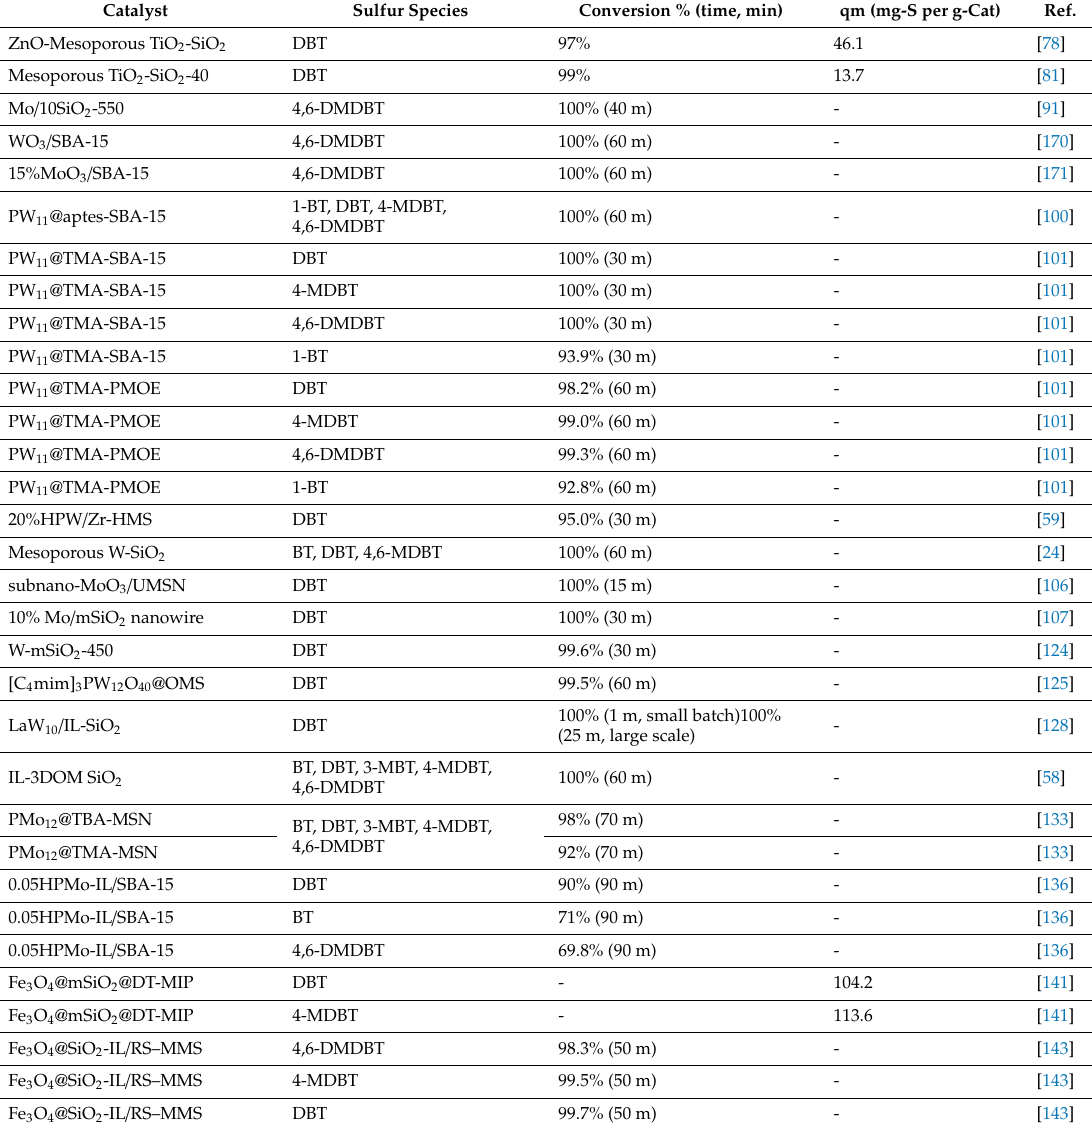
Table 1. Desulfurization e ffi ciency of di ff erent functionalized mesoporous silica materials. Catalyst Sulfur Species Conversion % (time, min) qm (mg-S per